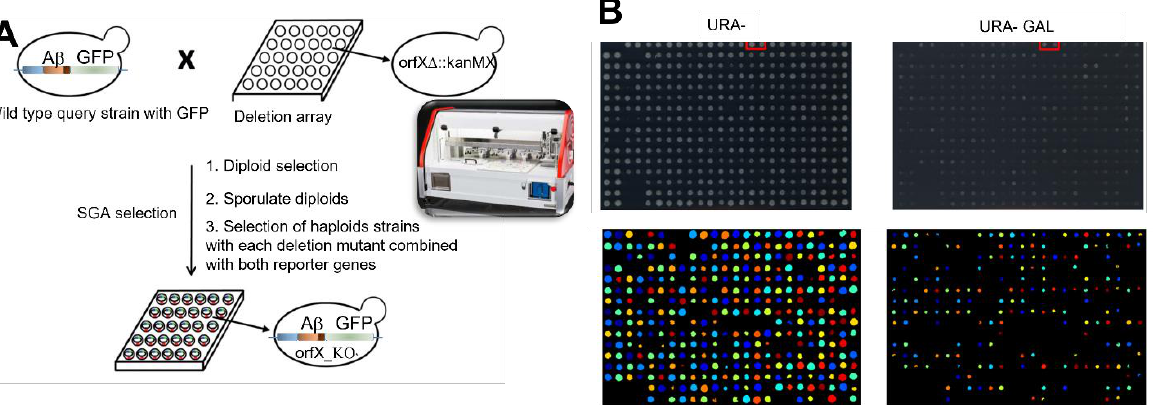
Figure 1. Genetic screening for modulators of Aβ toxicity. ( A ) Mating GAL10- MFα - Aβ 1 – 42 -GFP strain with KO yeast collection. A yeast strain overexpressing MFα - Aβ 1 – 42 -GFP was mated with a yeast collection of 5154 mutants. A synthetic genetic array (SGA) was performed as indicated in the M&M section to obtain mutant KO yeasts that overexpress MFα - Aβ 1 – 42 -GFP. ( B ) Phenotype comparison with and w/o galactose (upper panels) and quantification with Cell Profile (lower panels).